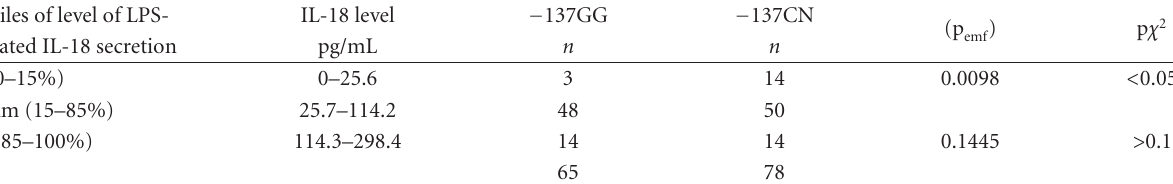
Table 2: Distribution of frequencies of IL-18 gene promoter genotypes at the − 137 G → C position in relation to the level of LPS-stimulated IL-18 secretion.